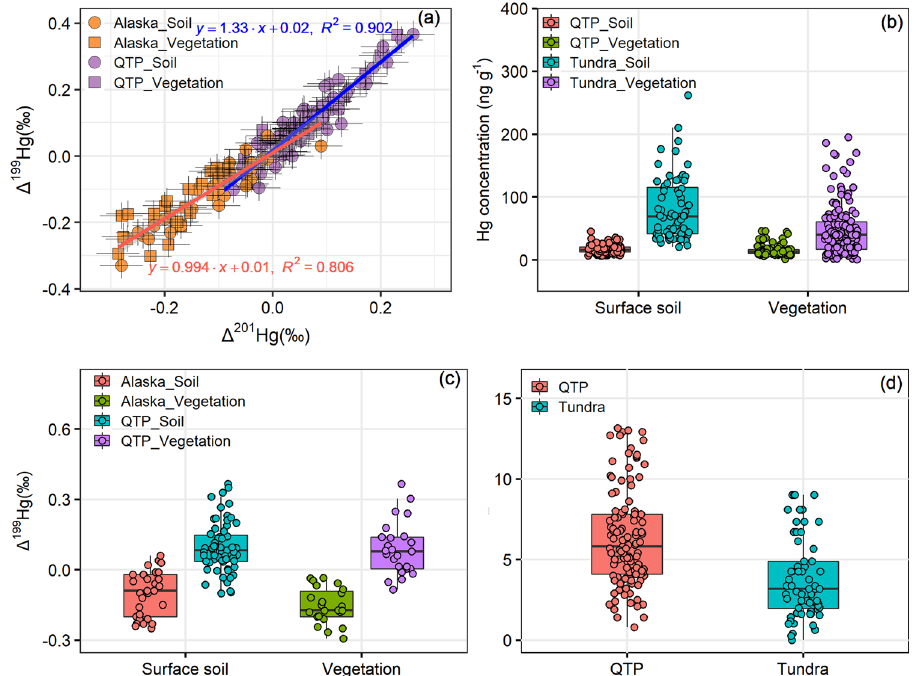
Fig. 5 Variation in mercury (Hg) isotopic composition across soil, vegetation, and region. a Comparison of slope for Δ 199 Hg versus Δ 201 Hg, b Hg concentrations, c Δ 199 Hg values in vegetation and 0 – 30 cm depth surface soils, d biomass ratio of root to shoot between the permafrost of QTP and Arctic tundra. Data of Hg concentration and isotopic compositions of Arctic tundra are based on literature synthesis 5,6,10,11,58 , including the regions of Alaska and Siberia, and the ratio of root to shoot for the grass species in the QTP and tundra are both from earlier studies 60 – 62 . Error bars stand for 1 σ in a . Boxplot elements in b – d show the median (midline), the interquartile range of 25% and 75% percentile (box boundaries), data points within the 1.5 × quartile range